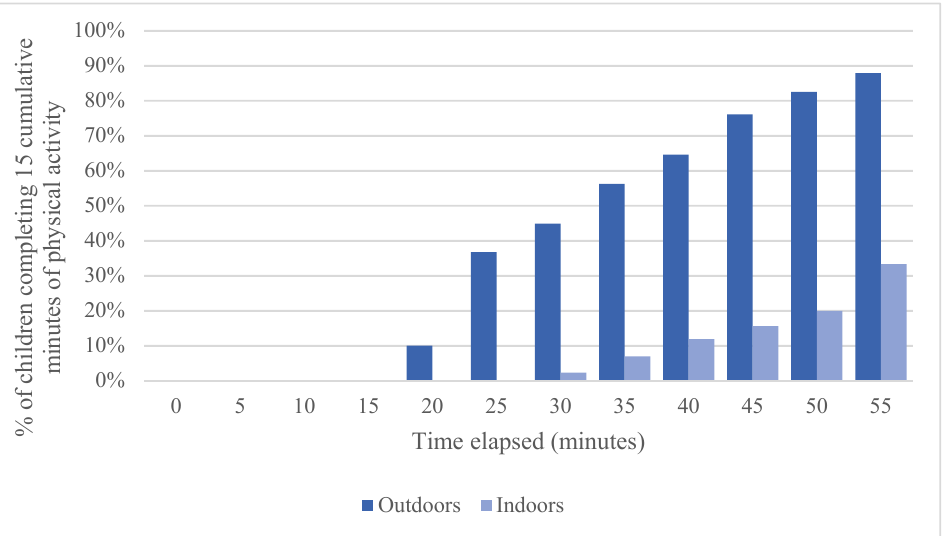
Figure 1. Percentage of children completing 15 min of physical activity during outdoor free-play versus indoor activities by elapsed time .